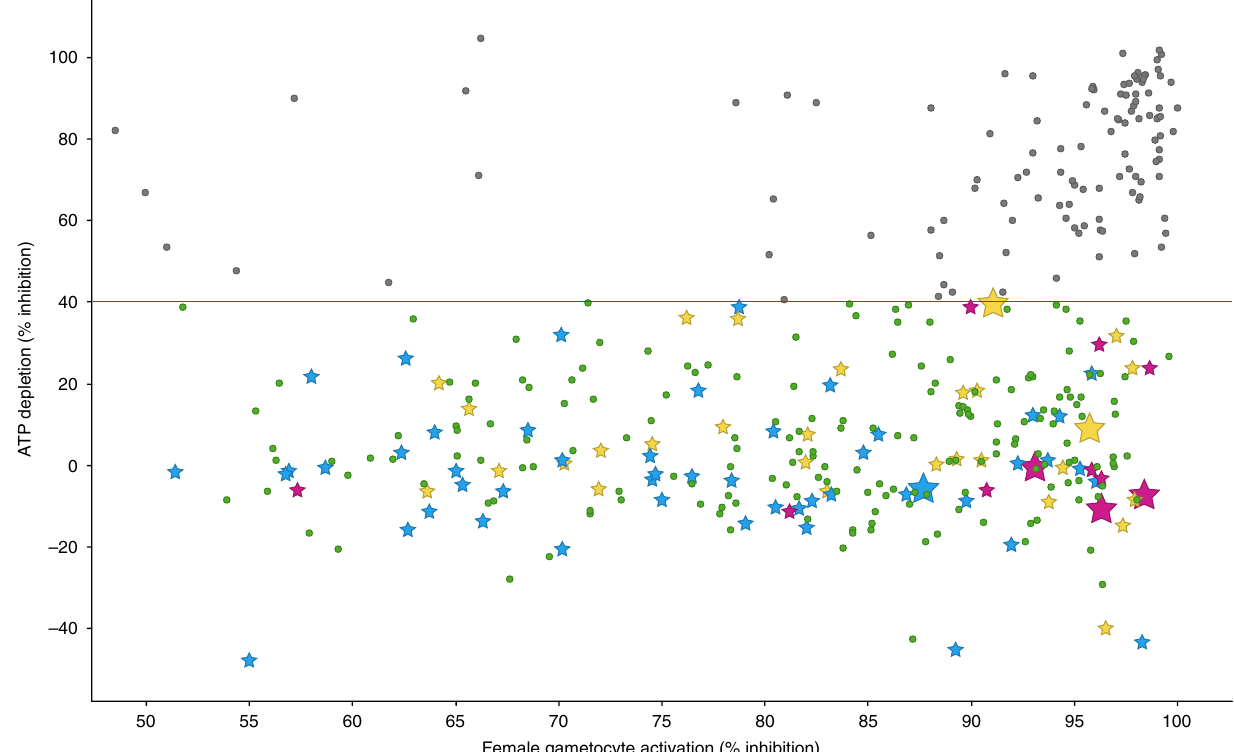
Figure 2 | Correlation graph of hits identified in the Pf FGAA screen compared to their activities in the ATP-depletion assay. 276 compounds (green circles and all stars) out of the 405 hits were exclusively identified in the Pf FGAA while 129 compounds (grey circles) were active in both assays. Stars represent those compounds further profiled: slow-acting (blue stars), fast-acting (yellow starts) and gamete-targeting (magenta stars). Compounds tested in the SMFA are marked as big